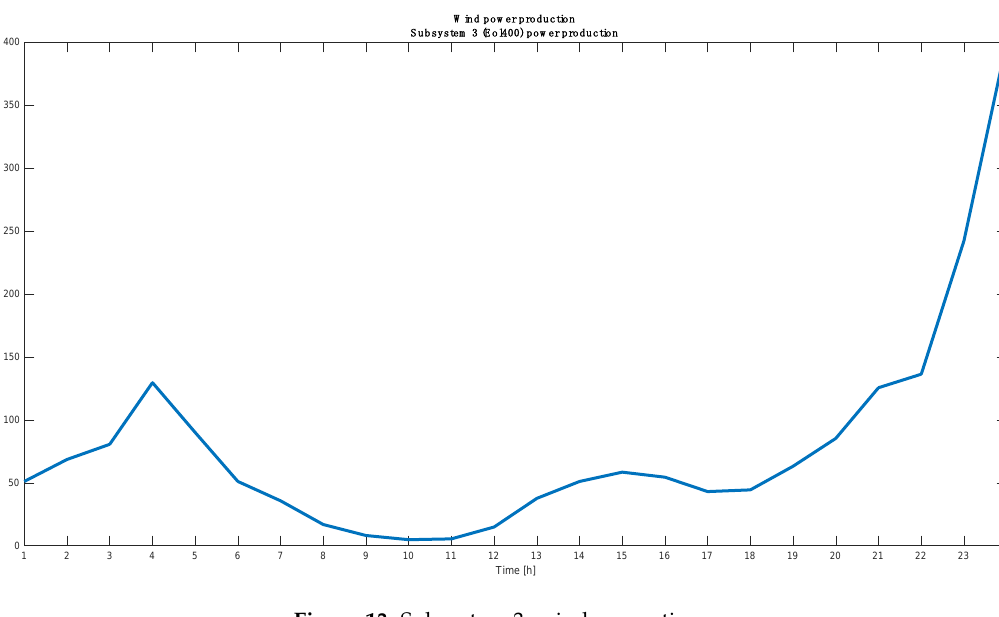
Figure 13. Subsystem 3: wind generation.